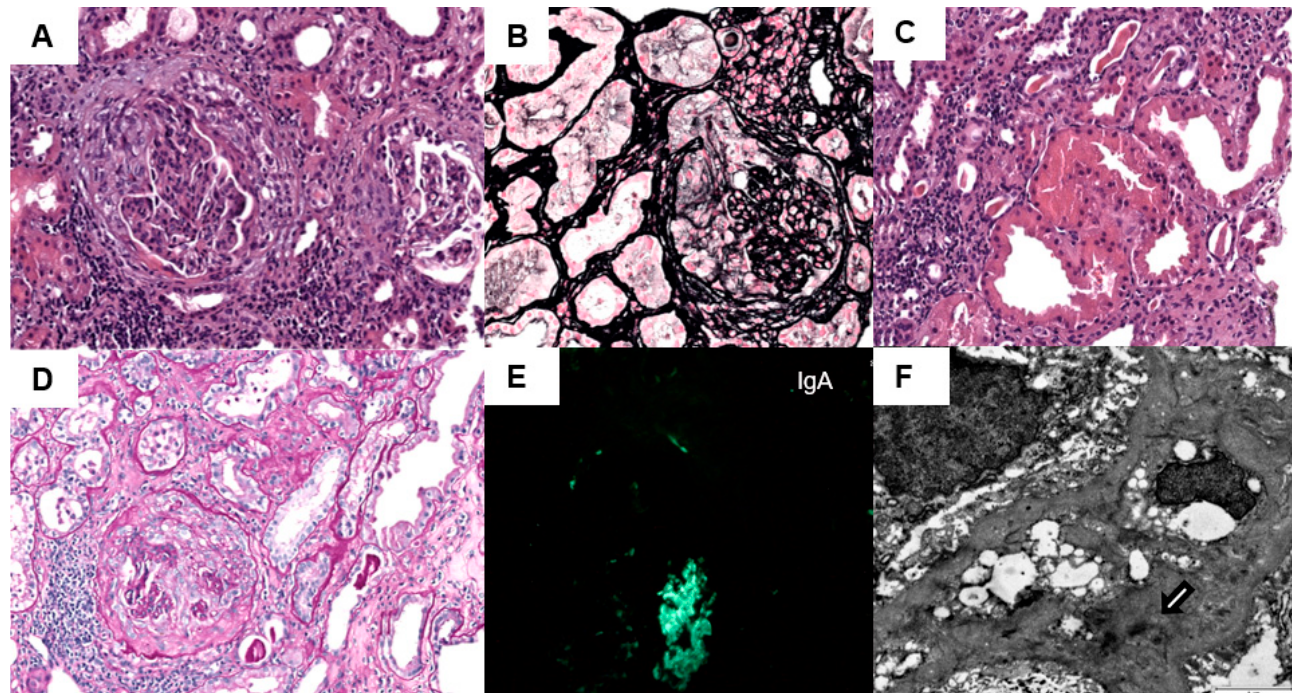
Figure 1. ( A ) Hematoxylin and eosin staining (×200), showing cellular crescents in two glomeruli. ( B ) Glomerulus showing a cellular crescent (Jones methenamine silver stain × 200). ( C ) tubules with dilation of tubular lumens, flattening of epithelium, simplification and loss of brush border (HE × 200). ( D ) Glomerulus showing a cellular crescent and tubules with dilated lumen and flattened regenerating epithelium; their lumens contain necrotic cellular debris (PAS × 200). ( E ) Immunoflourescence (IF) showing diffuse global granular deposits with IgA (2+) in mesangium (IF × 10). ( F ) Electronic microscopy examination showing mesangial electron-dense deposits (white arrow) (EM × 10,000).